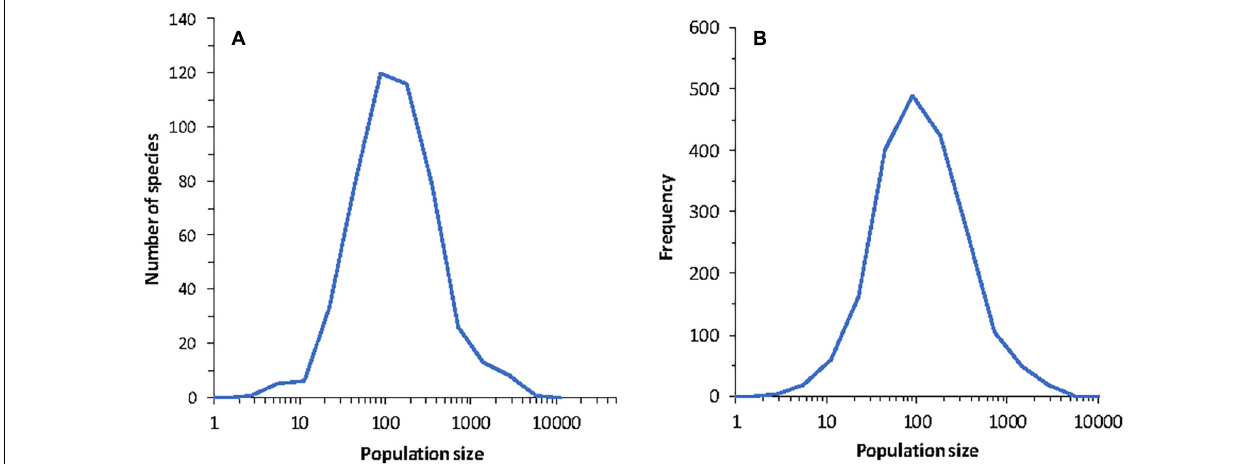
FIGURE 5 | (A) Species abundance distribution for a single community in one run of the model. (B) Histogram of population size in time for a run covering 2,000 years for a randomly chosen species from the community. The parameters of the model were J = 10 5 , K = 9, B = 1.5 and MVP = 2. The dynamics are according to Equation (10) and do not include extinction or